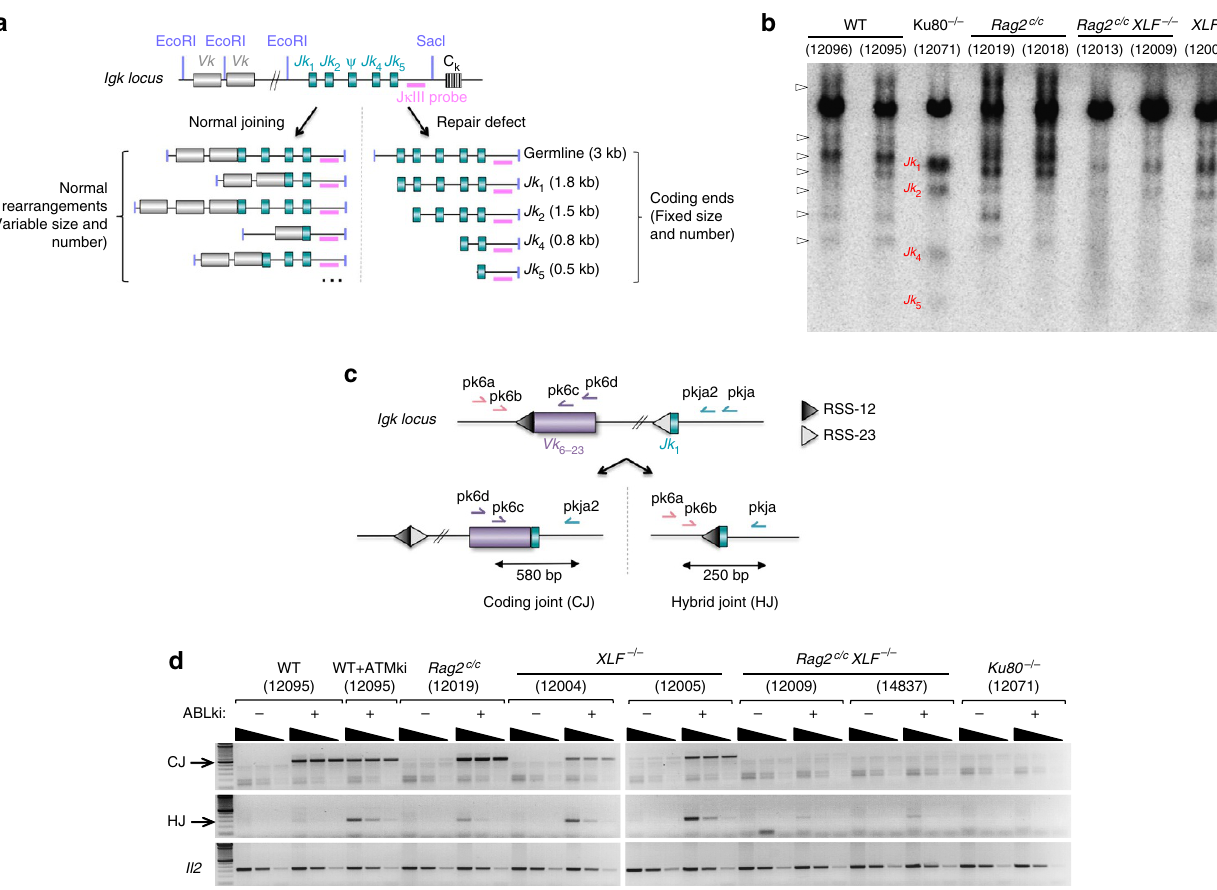
Figure 2 | Impaired rearrangement at the endogenous Igk locus in Rag2 c/c XLF (cid:2) / (cid:2) B cells. ( a ) Schematic representation of the Igk locus. The relative positions of the EcoRI and SacI restriction sites and the JKIII probe are shown. Schematic representations of SacI/EcoRI digest fragments for normal Vk-Jk rearrangements (left) and the Jk1 , Jk2 , Jk4 , and Jk5 coding ends (CE) (right) are represented. SacI/EcoRI digest fragments from Vk-Jk rearrangements are variable in size depending on the Vk and Jk gene segments used and the relative positions of EcoRI/SacI sites, whereas the size of Jk1 , 2 , 4 and 5 coding ends fragments are 1.8, 1.5, 0.8 and 0.5kb, respectively. ( b ) Southern blot (using JKIII probe) of EcoRI/SacI digested DNA from v-abl pro-B cell lines treated for 72h with ABLki (see also Supplementary Fig. 2). Arrows indicate normal rearrangements. Jk 1–5 CEs are indicated in red. ( c ) Schematic representation of the Igk locus with position of primers (arrows) used to assay CJ and HJ formation during inversional IgkV 6–23 -J 1 rearrangement. ( d ) Semi-quantitative nested PCR analysis of IgkV 6–23 -J 1 CJ and HJ from indicated v-abl abl pro-B cell lines treated for 72h with ABLki with or without ATMki. Il2 gene PCR was used as a loading control. The data presented are representative of at least two experiments using independent cell